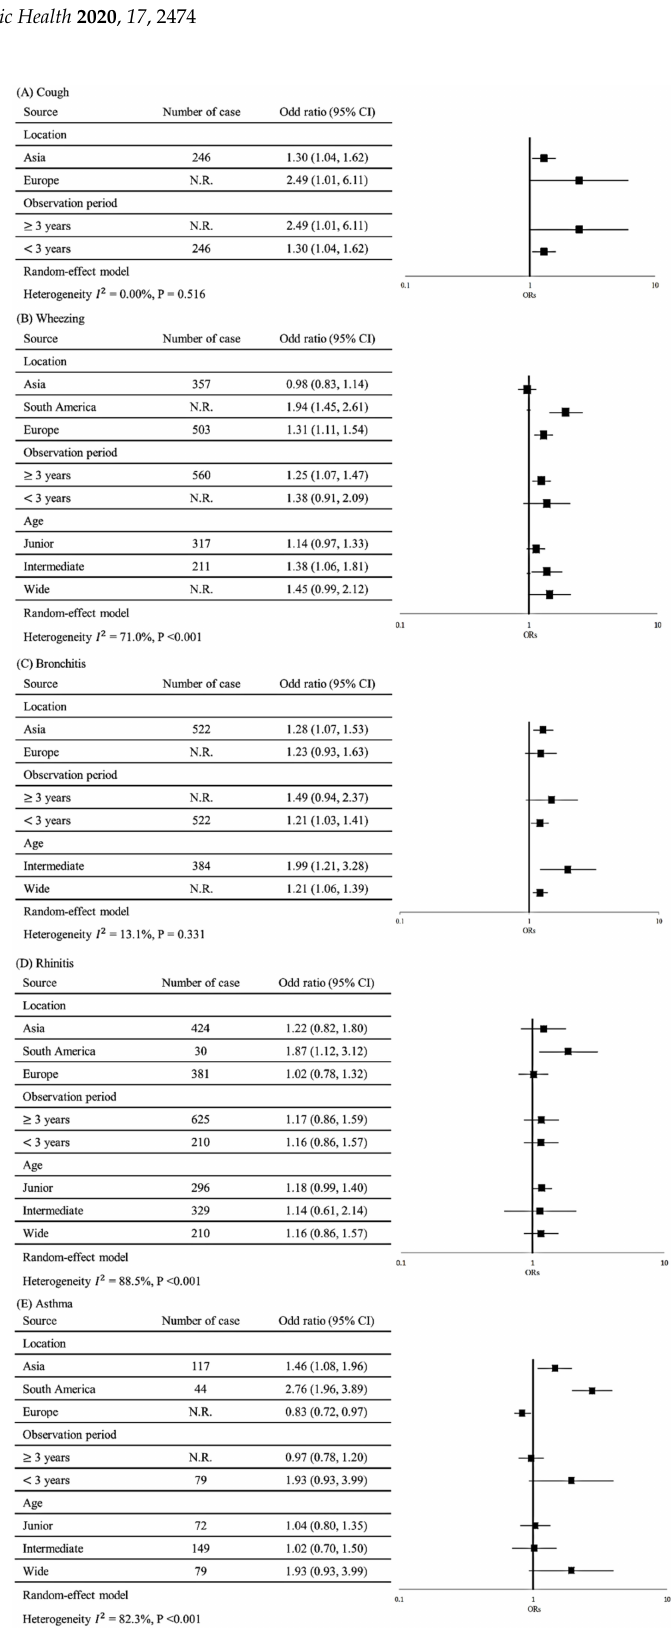
Figure 4. Subgroup analyses of studies on the risk of five respiratory symptoms among residents near petrochemical industrial complexes. ( A ) Subgroup analyses of studies on cough; ( B ) subgroup analyses of studies on wheezing; ( C ) subgroup analyses of studies on bronchitis; ( D ) subgroup analyses of studies on rhinitis; ( E ) subgroup analyses of studies on asthma. N.R., nonreported; 95% CIs, 95% confidence